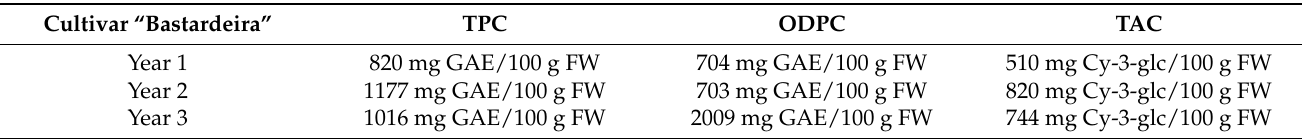
Table 2. Effect of harvesting year on the yields of TPC, TAC, and ODPC of the cultivar “Bastardeira”. Cultivar